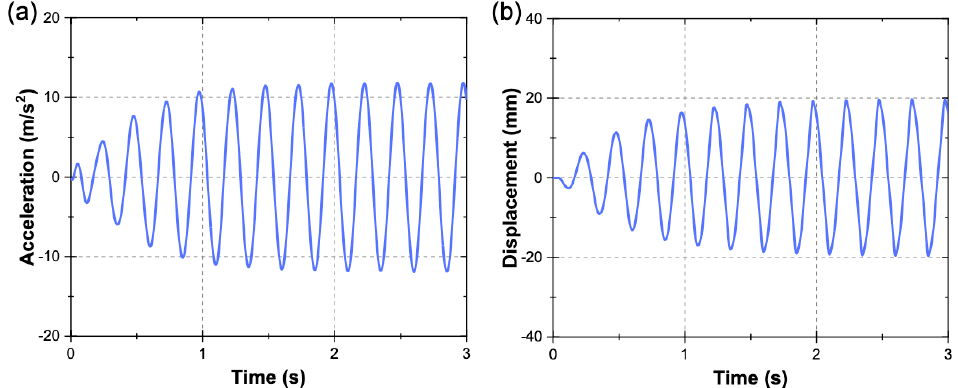
Figure 5. Acceleration and displacement measured by the built-in sensors of the shaking table: ( a ) acceleration–time history and ( b ) displacement–time history.